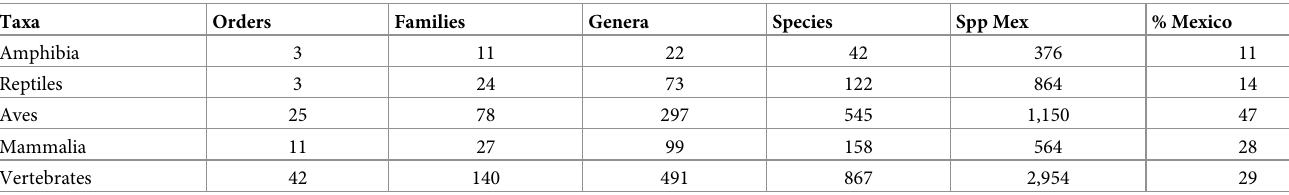
Table 1. Vertebrate species in Colima and contribution to Mexican species richness. Taxa